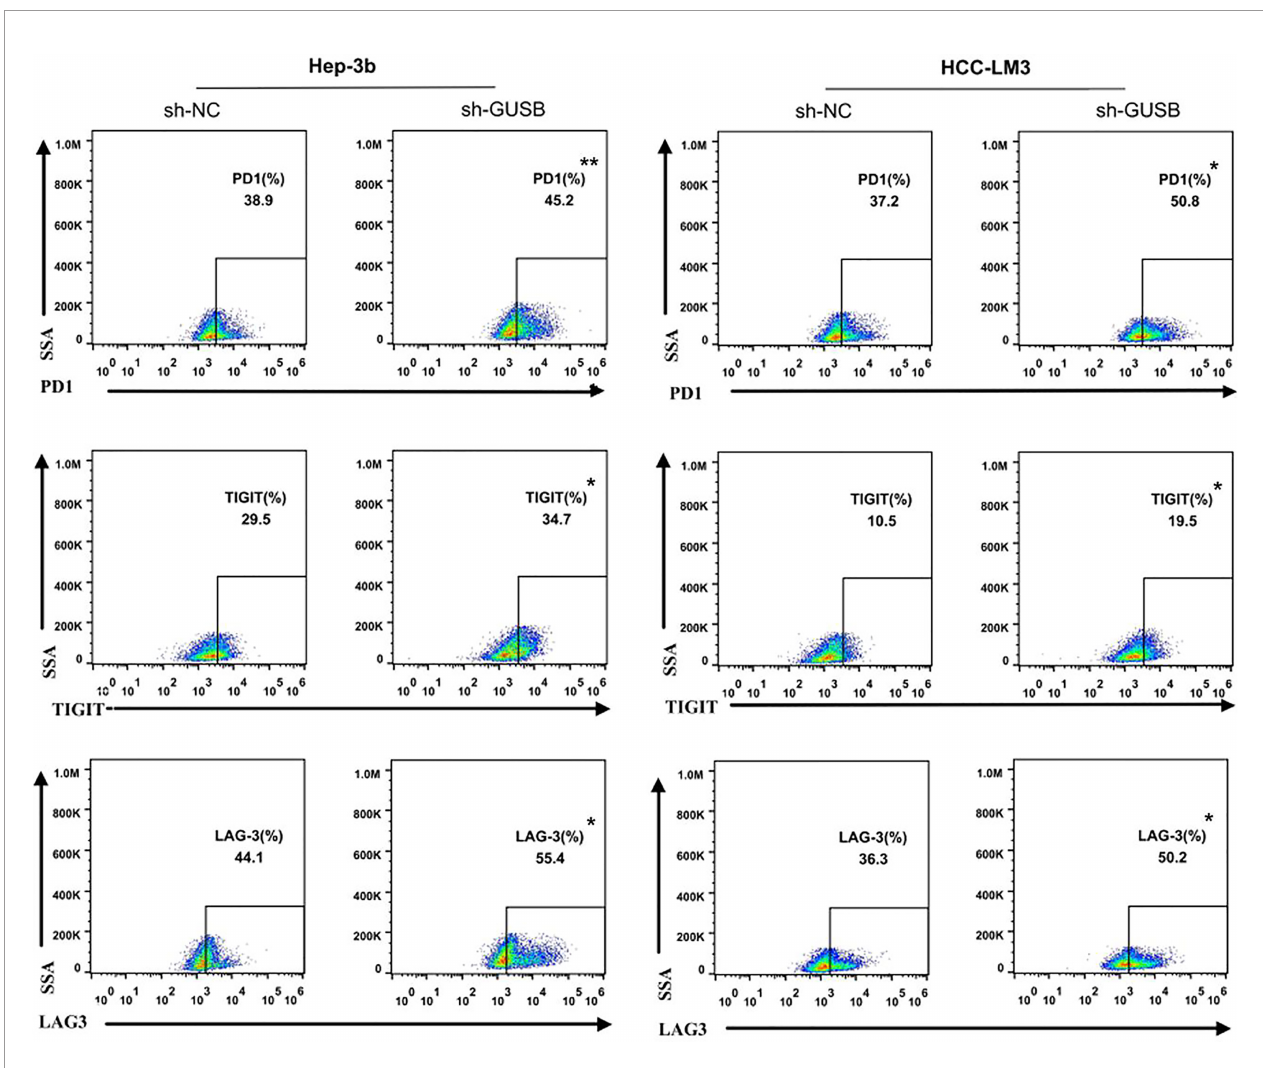
FIGURE 2 | Knocked down of GUSB promoted the CD8 + T-cell exhaustion markers expression when co-cultured with antigen-speci fi c CD8 + T cells isolated from 3 PBMC samples. HCC cells treated with sh-NC/sh-GUSB were co-cultured with antigen-speci fi c CD8 + T cells, and the expression of common markers of CD8 + T-cell exhaustion (LAG3, PD1, and TIGIT) was measured by fl ow cytometry. * P < 0.05; ** P <